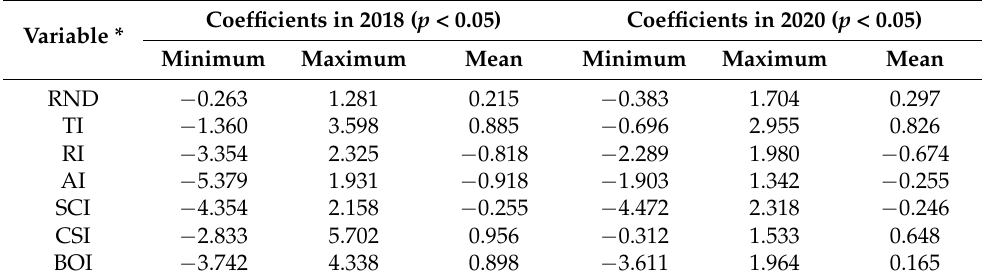
Table 5. The MGWR coefficients of 7 variables in 2018 and 2020. Coefficients in 2018 ( p < Variable *